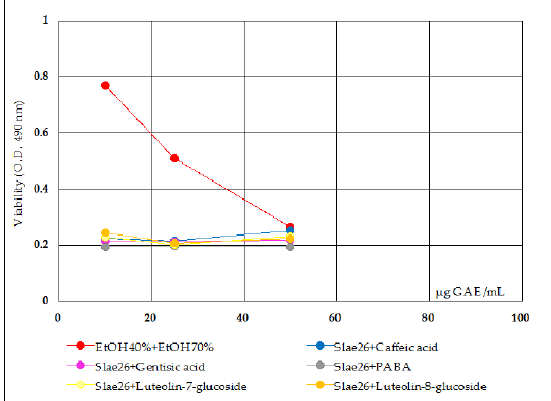
Figure 5. Antiproliferative activity of the Slae26, tested on Caco-2, BT20 and B16 cell lines, at 48 h.